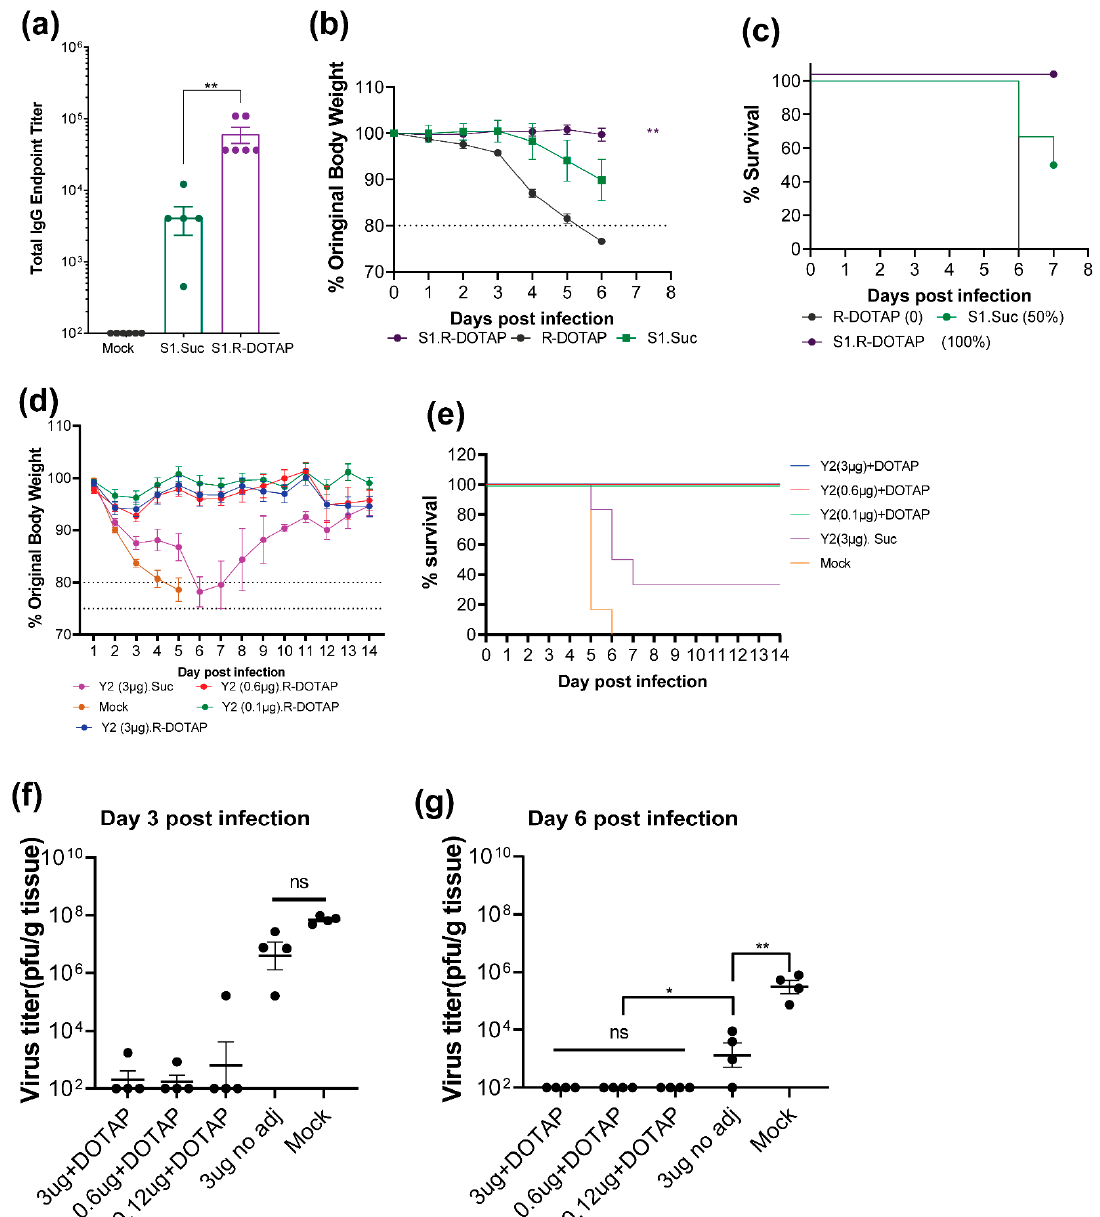
Figure 7. Mice vaccinated with Recombinant vaccines adjuvanted with R-DOTAP are protected from viral challenge. Groups ( a – c ) of K18hACE2 transgenic mice ( n = 6) mice were intramuscularly injected on day 0 and day 28 with vaccine formulations containing recombinant SARS-CoV2 Spike S1 protein (10 μ g/dose) in sucrose buffer (S1. Suc) or formulated with R-DOTAP nanoparticles (S1. R-DOTAP) or R-DOTAP nanoparticle alone (R-DOTAP). All vaccinated mice were challenged in- tranasally with SARS-CoV2 virus (2.5 × 10 4 pfu/dose) (2019n-CoV/USA_WA1/2019 isolate) and weight loss and survival over an 8-day period was monitored. Mice that lost 20% of body weight